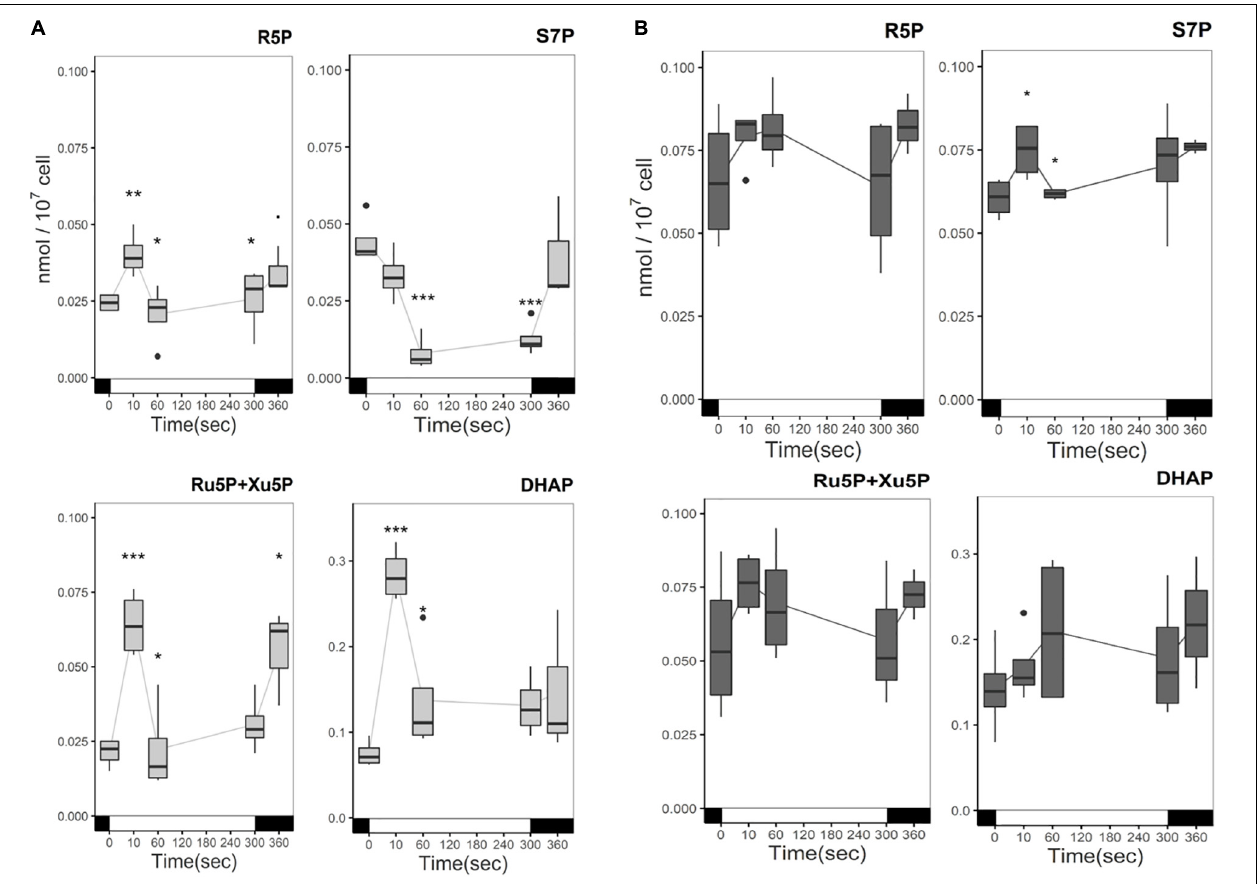
FIGURE 5 | Time course of CBB intermediates metabolites in the absence (A) or presence (B) of acetate under illumination. Cells were irradiated with 300 µ mol photons m − 2 s − 1 (white segment) and samples were taken at different time points. In the absence of acetate, light significantly affected the accumulation of CBB intermediates ( p -value < 0.05). Pairwise t -test were performed between time points (one asterisk, p < 0.05; two asterisks, p < 0.01; three asterisks, p < 0.001). Light had no significant effect in the presence of acetate. The boxplot has been built with four replicates. The line represents the mean. The dots represent outlier data that has been taken into account for standard error and statistics, designated as a dot in the whisker